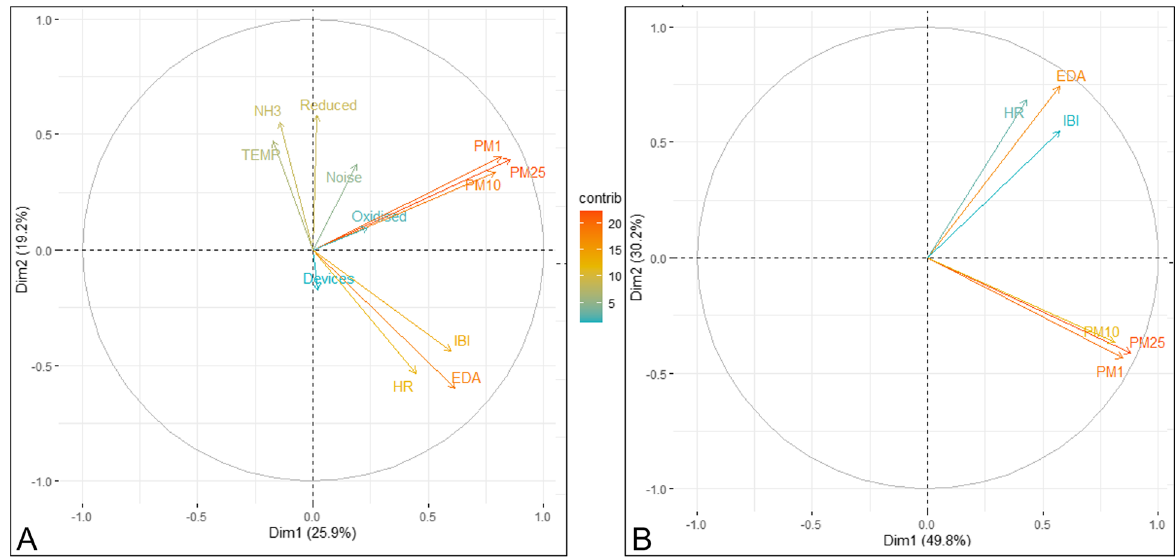
Fig. 7 PCA Analysis - A Variance between the different variables, B Variance between the different variables without